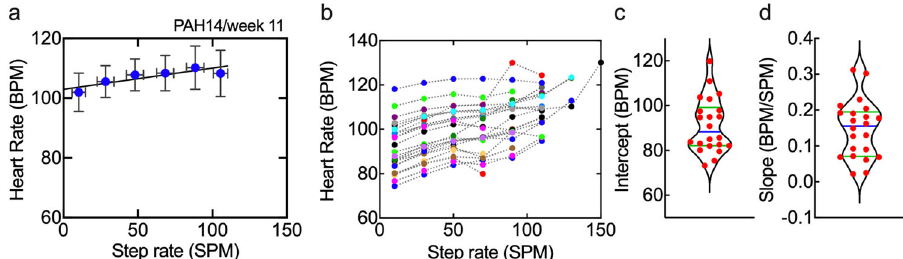
Fig. 3 Assessment of fi tness. a The average step rate and corresponding average heart rate in 20 SPM bins for PAH 14 in week 11. Bars represent mean ± SD. b Mean step rate versus mean heart rate plots averaged over all weeks for each individual. c Fitness intercept (BPM) and d fi tness slope (BPM/SPM) obtained from a linear least-squares fi t to the HR-SR plots for each individual. Blue bar – mean; green bars – upper and lower